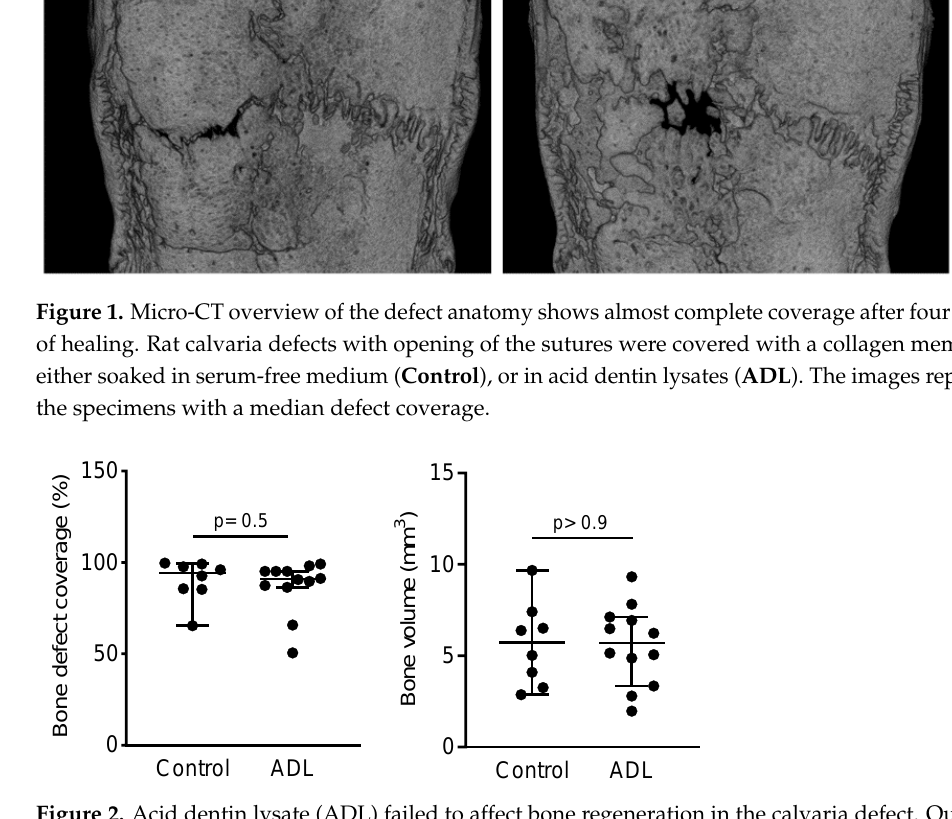
Figure 2. Acid dentin lysate (ADL) failed to affect bone regeneration in the calvaria defect. Quantita- tive analysis of bone defect coverage (%) and bone volume (mm 3 ) in the inner 4.5 mm of the defect. The two groups were compared with Mann–Whitney U test and p values are indicated.